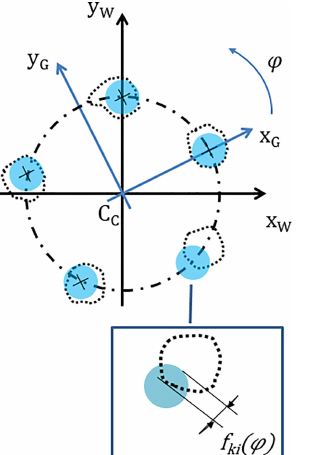
Figure 4. Hole-pattern fit of the flange. In the actual alignment, the gauge overlaps with the extracted workpiece which is outlined by the black dots intersecting with the circular gauge